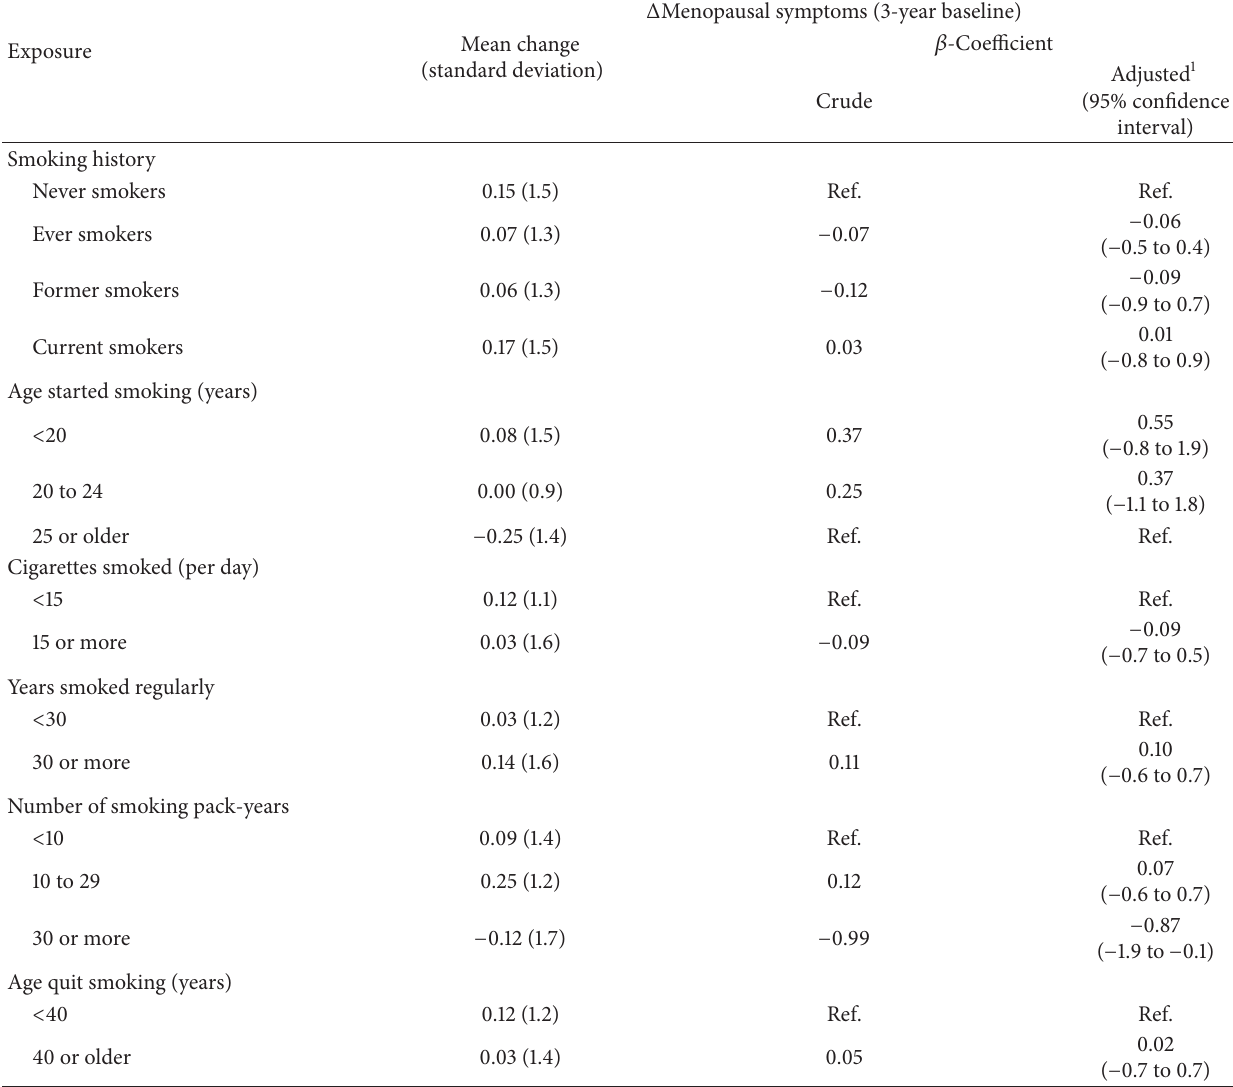
sclerosis in the Women’s Health Initiative Observational